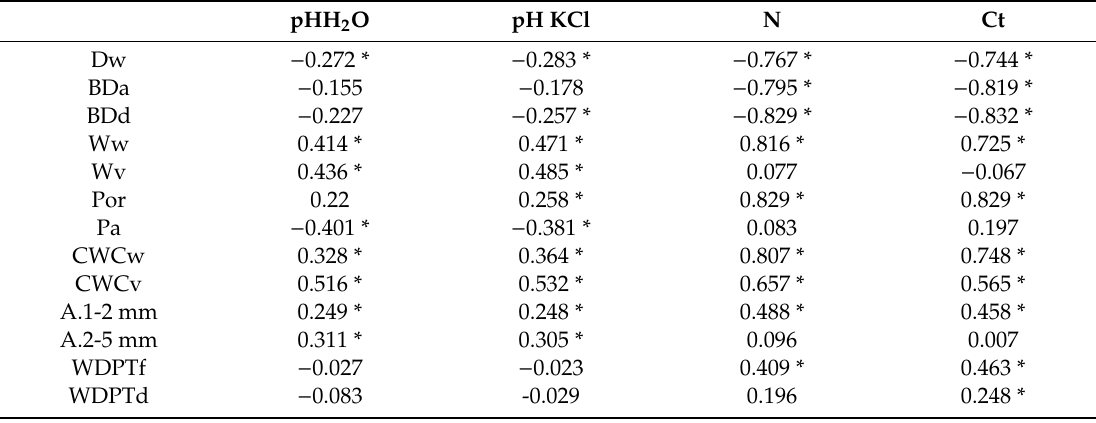
Table 6. The Pearson correlation coe ffi cients between physical and chemical properties.